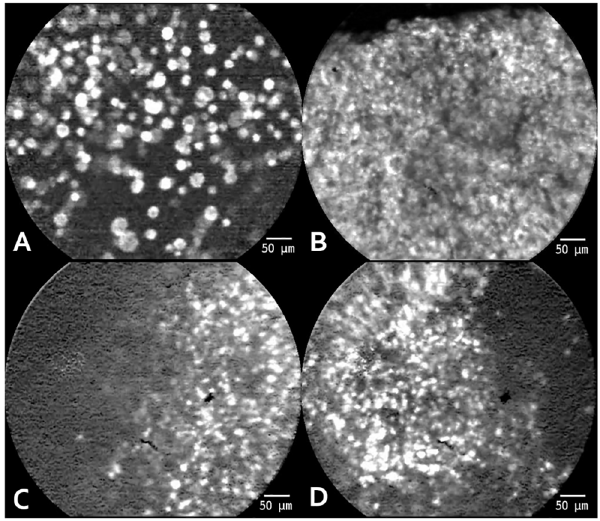
Fig 4. pCLE findings. pCLE on day 3 shows spontaneous and intense signal compatible with successful cell sheet transplantation. This signal was similar to those whom obtain in vitro . No signal was found at day 14 and 28 pCLE evaluation. A. ADSC visualized in vitro with pCLE, in suspension. B. ADSC visualized in vitro organized in cell sheet. C and D. ADSC visualiazed in vivo after successful cell sheet